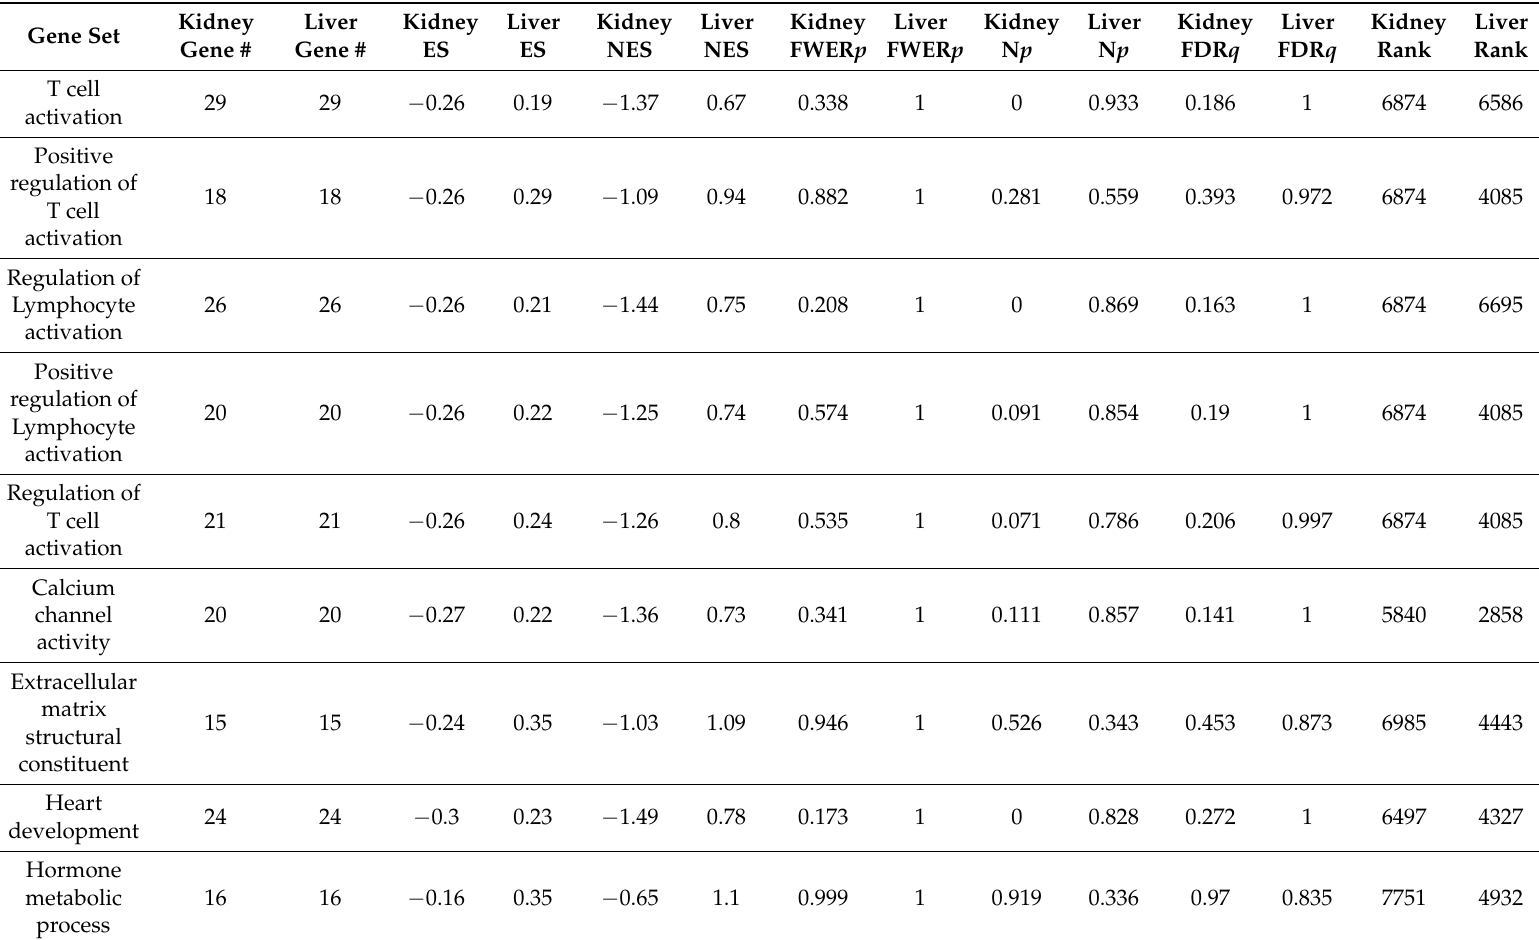
Table 1. Genes Upregulated in Liver and Downregulated in Kidney during